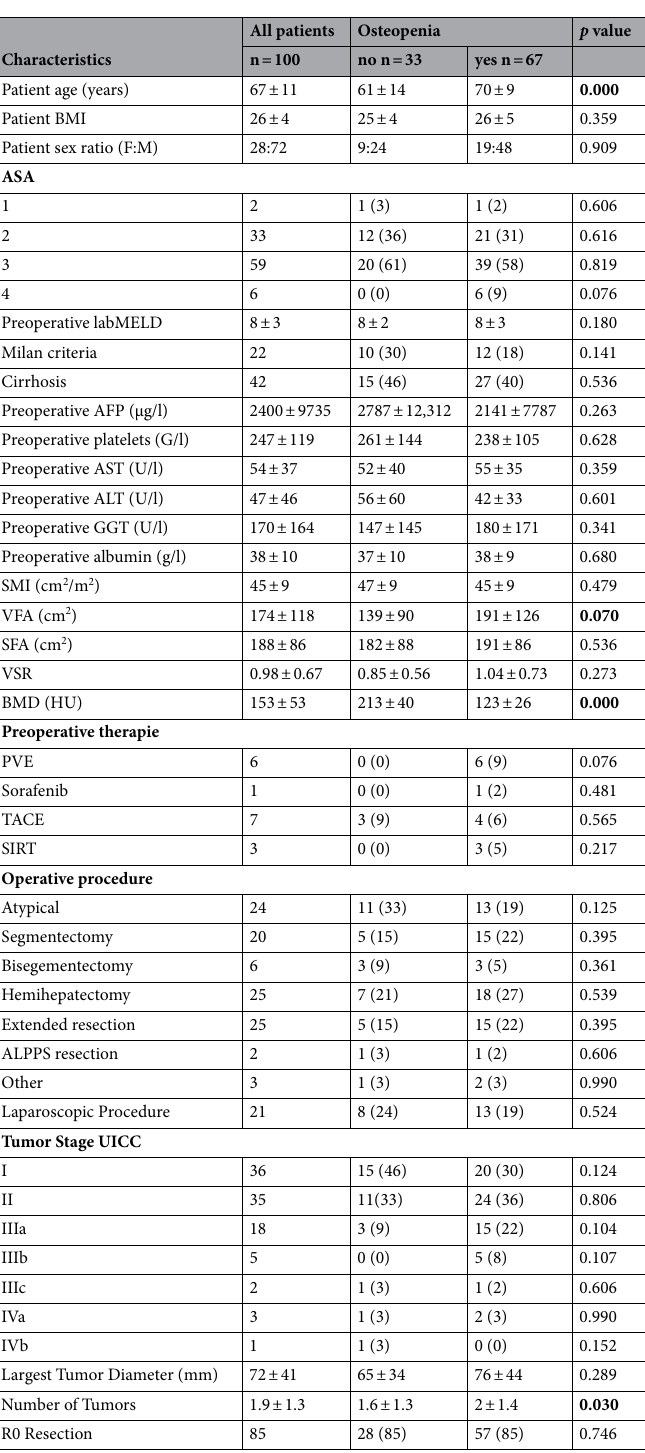
Table 1. Patient and procedural characteristics. Values were given as mean ± standard deviation or absolute and relative frequencies (per cent). 1 Refers to Clavien et al. 26 3 Refers to Slankamenac et al. 27 4 Refers to Staiger et al. 29 . BMI Body mass index; ASA American Society of Anesthesiologists; MELD model for end-stage liver disease; AFP alphafetoprotein; AST Aspartate aminotransferase; ALT Alanine aminotransferase; GGT Gamma glutamyltransferase; SMI Sceletal muscle index; VFA Visceral fat area; SFA Subcutanous fat area, VSR Visceral-to-subcutaneous fat ratio; BMD ( HU ) Bone mineral density (Hounsfield units); PVE Portal venous embolization; TACE Transarterial chemoembolization; SIRT Selective internal radiotherapy; UICC Union for International Cancer Control. Significant values are in